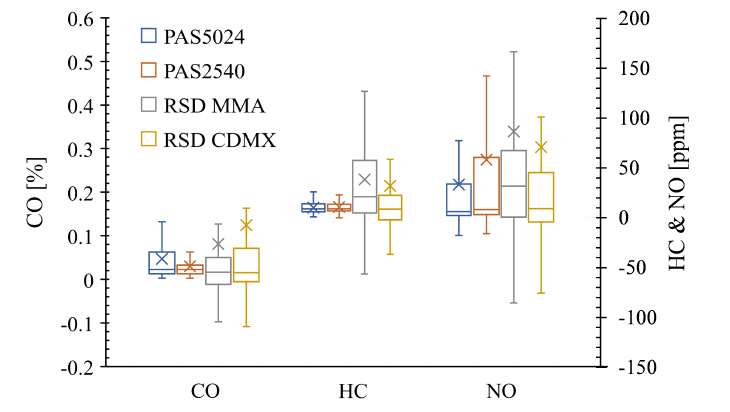
Figure 6. Boxplots of the CO, HC (hexane equivalent), and NO tailpipe concentrations for the one-year-old single model from RSD and the ASM I/M program (PAS5024 & PAS2540) for MMA and Mexico